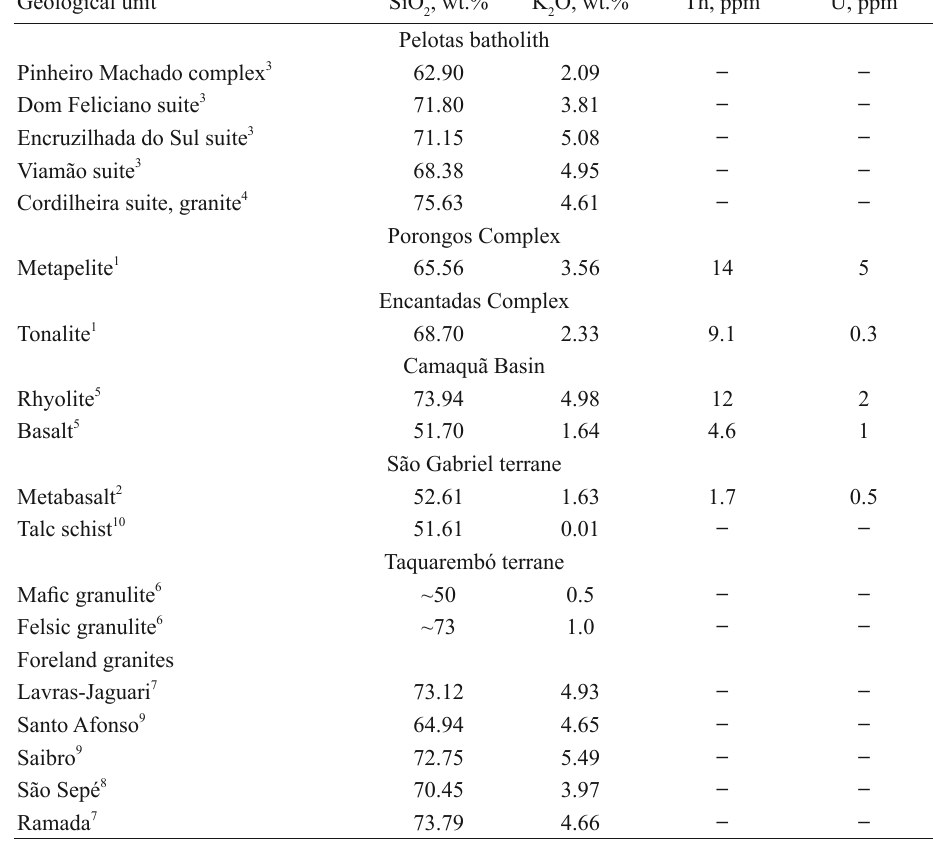
Selected chemical compositions of geological units from the Sul-Riograndense Shield; ( ̶ ) = not